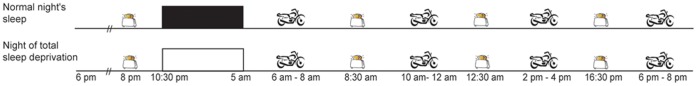
Experimental protocol.Each participant participated in two days of test sessions, organised after either a normal night’s sleep or a night of TSD. During these days, standardised meals were provided between test sessions.